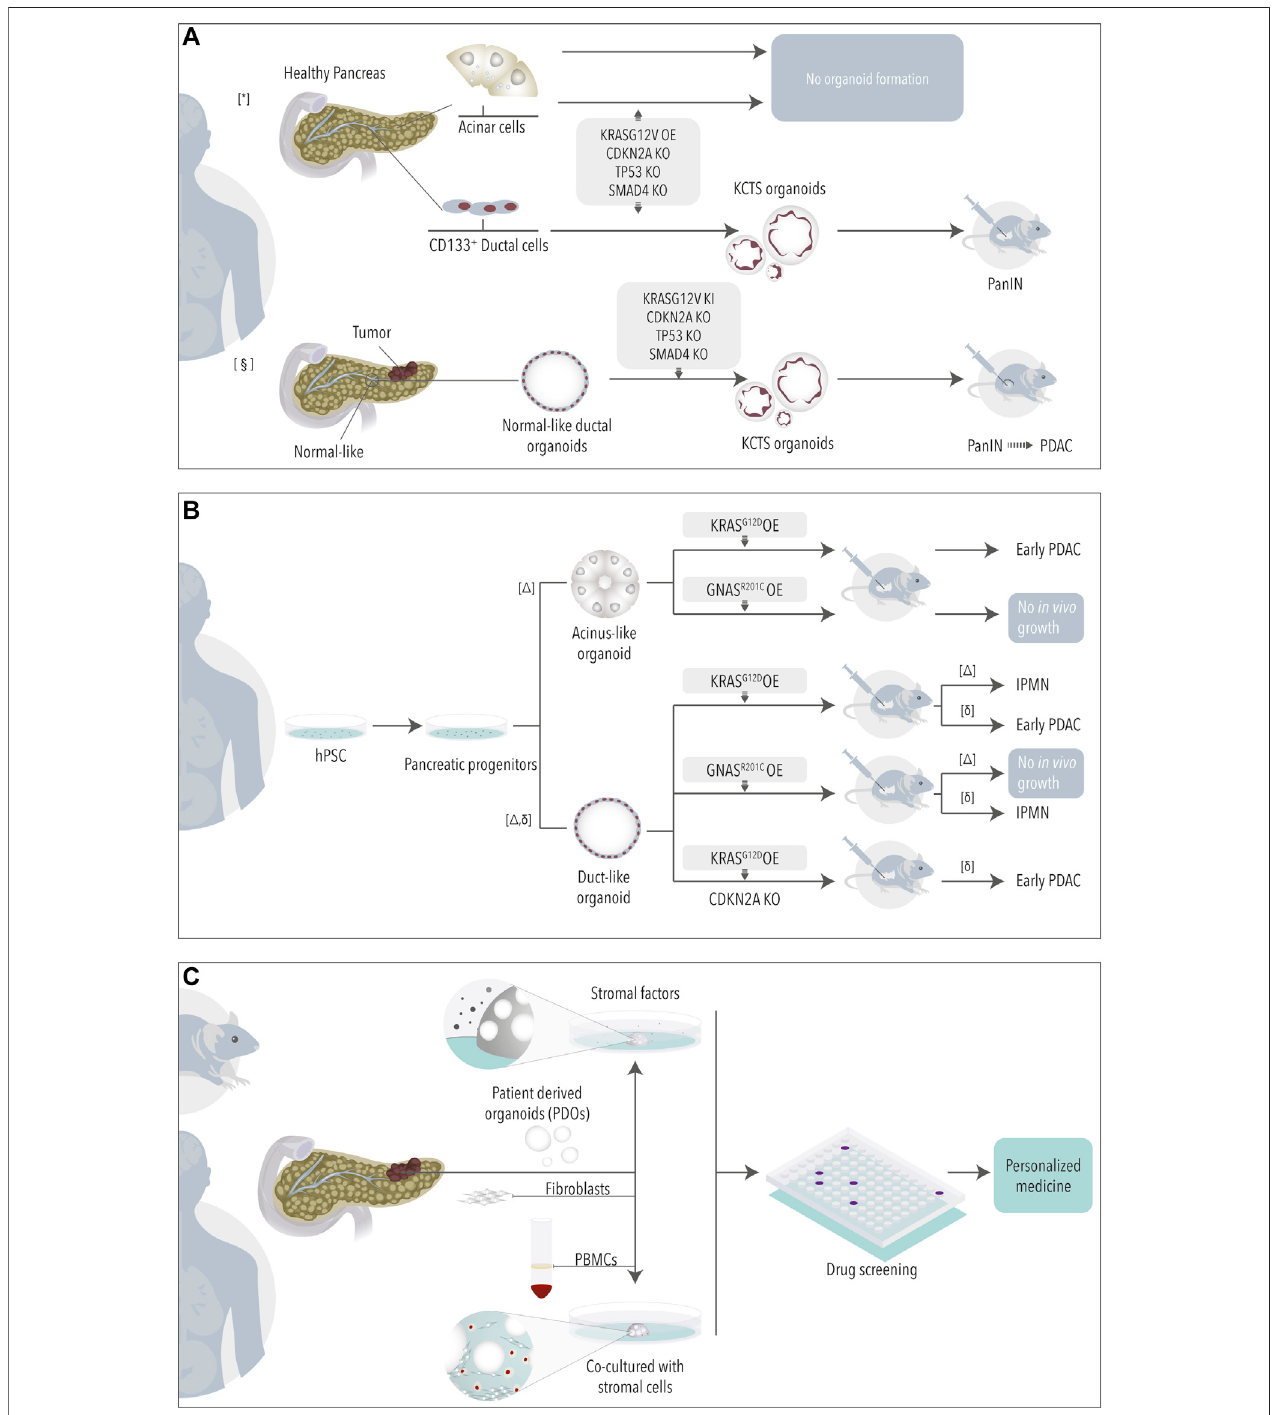
FIGURE 2 | Organoids for cancer research. Non-tumoral organoids derived from healthy or normal-like tissue adjacent to tumor (A) or from pluripotent stem cells (B) have been engineered to study the role of PDAC driving mutations. (C) Tumoral organoids in mono- or co-cultures are used as model for drug testing. * (Lee et al., 2017) § (Seino et al., 2018) Δ (Huang et al., 2021), δ (Breunig et al., 2021).